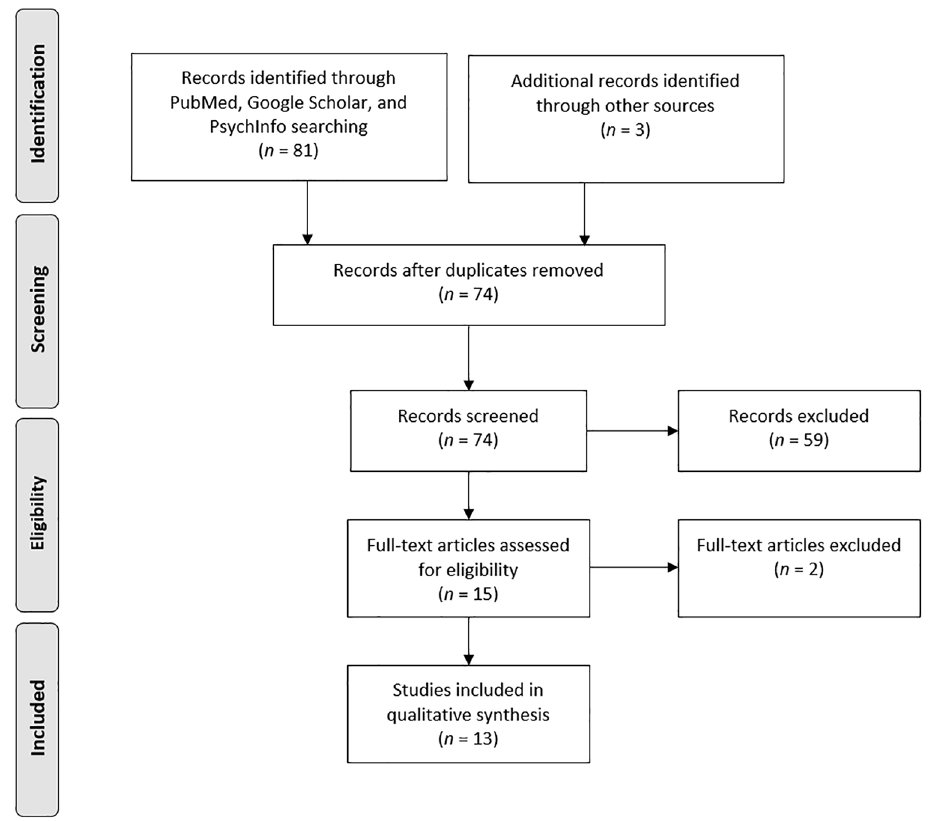
Figure 1. Flow diagram of the extracted